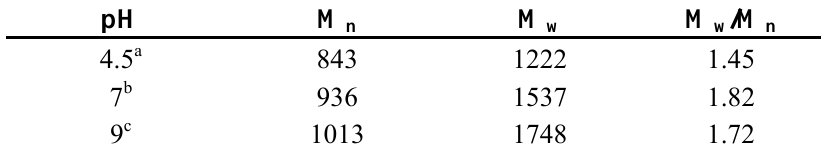
Table 2. Results of GPC analyses on the oxidation products of isoeugenol with CuSS at different pH. a buffer solution 0.1 M Citric acid/Citrate. b buffer solution 0.1